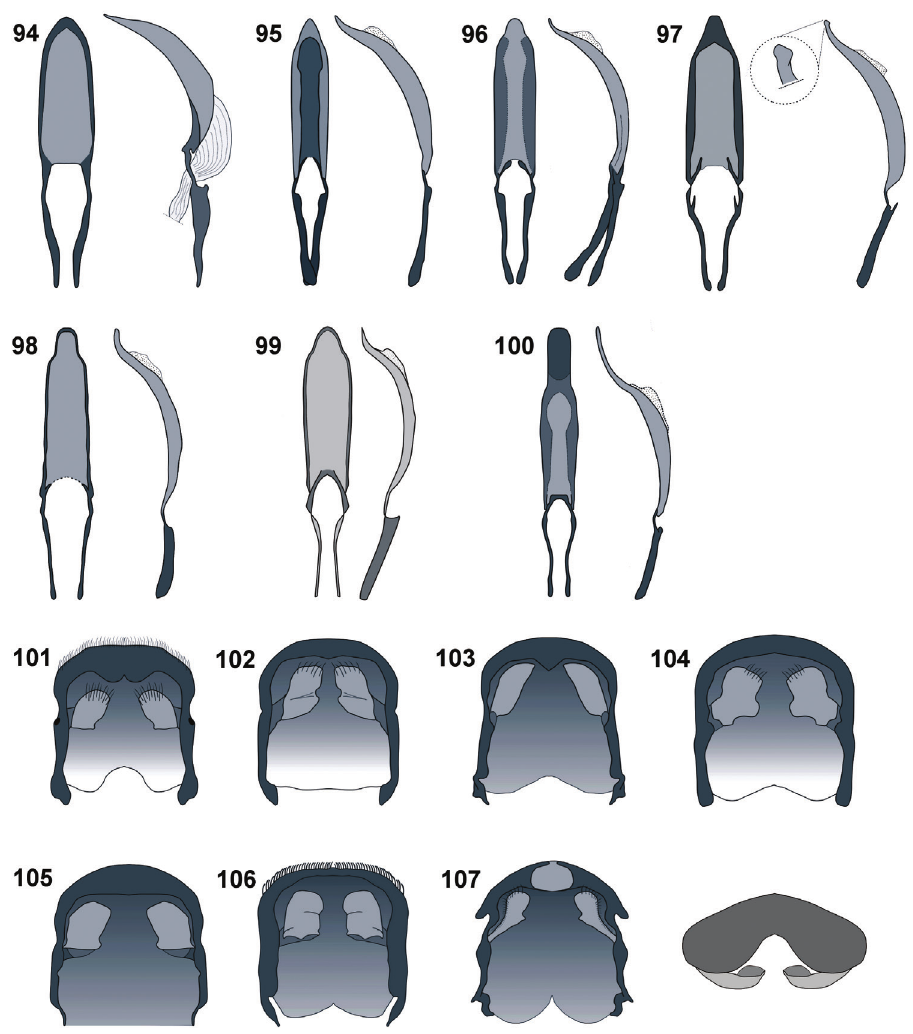
Figures 94–107. Penis: 94 C. farinosus Perr. 95 C. fundatus sp. n. 96 C. gibbus sp. n. 97 C. malleus sp. n. 98 C. rutai sp. n. 99 C. torosus sp. n. 100 C. turbidus sp. n. Male pygidium, ventral view: 101 C. farinosus Perr. 102 C. fundatus sp. n. 103 C. gibbus sp. n. 104 C. malleus sp. n. 105 C. rutai sp. n. 106 C. torosus sp. n. 107 C. turbidus sp. n – ventral and frontal view. on rostrum distinct, medially covered with scales, surface between eyes and on apical part of rostrum shining. Scape shorter than rostrum (scl/rl ♂ : 0.82; ♀ : 0.83). First funicle segment 1.60 × as long as 2 nd ; 3 rd 0.65 × as long as 2 nd ; 4 th slightly longer than wide; from 5 th to 7 th as long as wide. Club slender, 2.50 × as long as wide; as long as last four funicle segment combined. Setae on antennomeres distinct, elongate, moderately